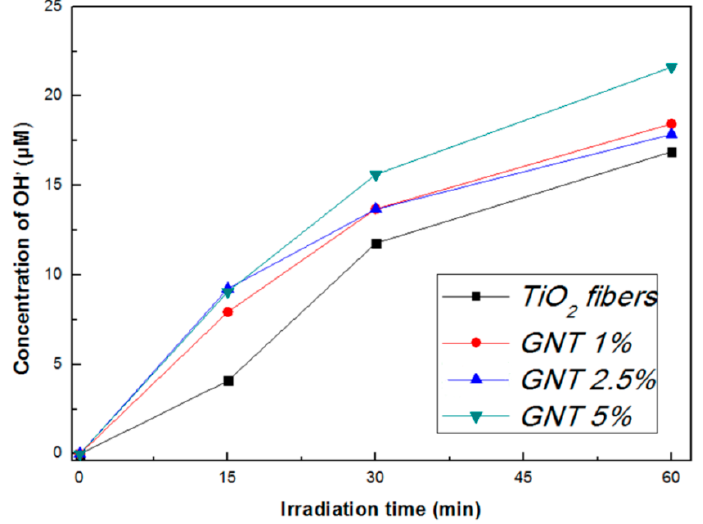
Figure 9. Evolution of hydroxyl radicals ( • OH) as determined by fluorescence against irradiation time for TiO 2 , and GNT 1%, GNT 2.5% and GNT 5% composite photocatalysts. Table 2. Formation rate of • OH radicals after 60 min of irradiation and correlation coe ffi cient for linear model as well as the photocatalytic degradation of methylene blue for the prepared fibrous catalysts.